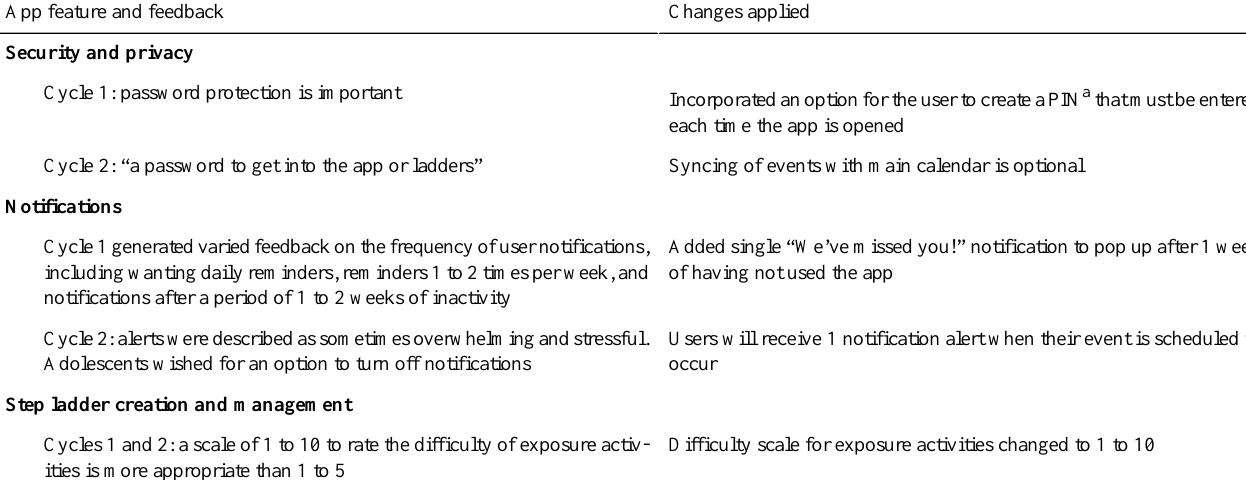
Table 2. Summary of adolescent feedback generated during usability testing cycles that was incorporated into